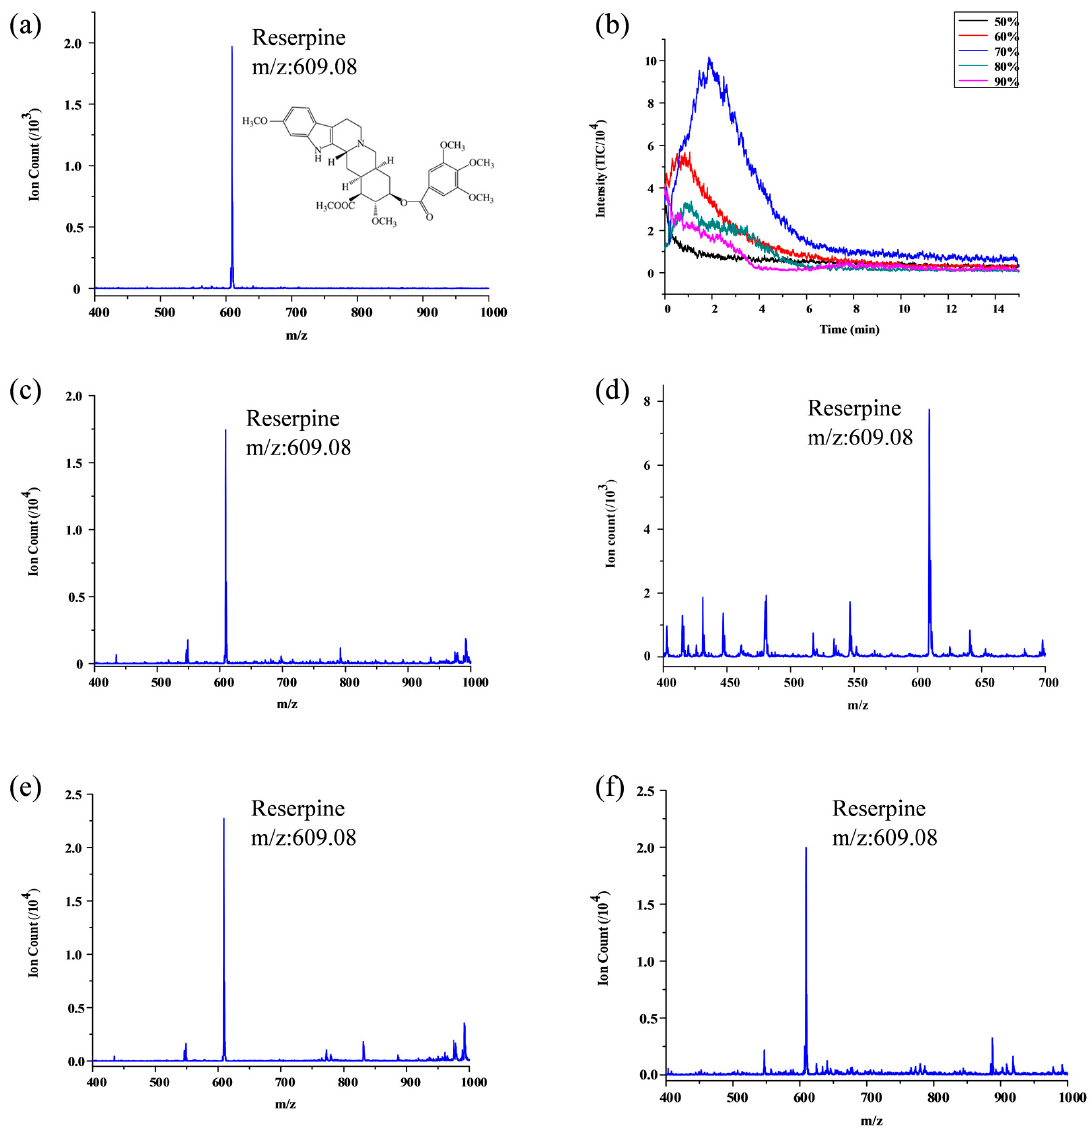
Figure 4. Results of SPME using standard sample: ( a ) Reserpine ion counts of the 15 min mean signal by commercial capillary; total ion current (TIC) mass range from 400 to 1000; ( b ) Different acetonitrile and water ratio with 1% formic acid used as eluent and reserpine signal change within 15 min on elution; TIC mass range from 609 to 610; ( c ) Reserpine ion counts by the FF ESI emitter that the depth of the nozzle is 260 µm; ( d ) Reserpine ion counts by the corner-integrated ESI emitter that the depth of the nozzle is 260 µm; ( e ) Reserpine ion counts by the FF ESI emitter that the depth of the nozzle is 40 µm; ( f ) Reserpine ion counts by the corner-integrated ESI emitter that the depth of the nozzle is 40 µm.